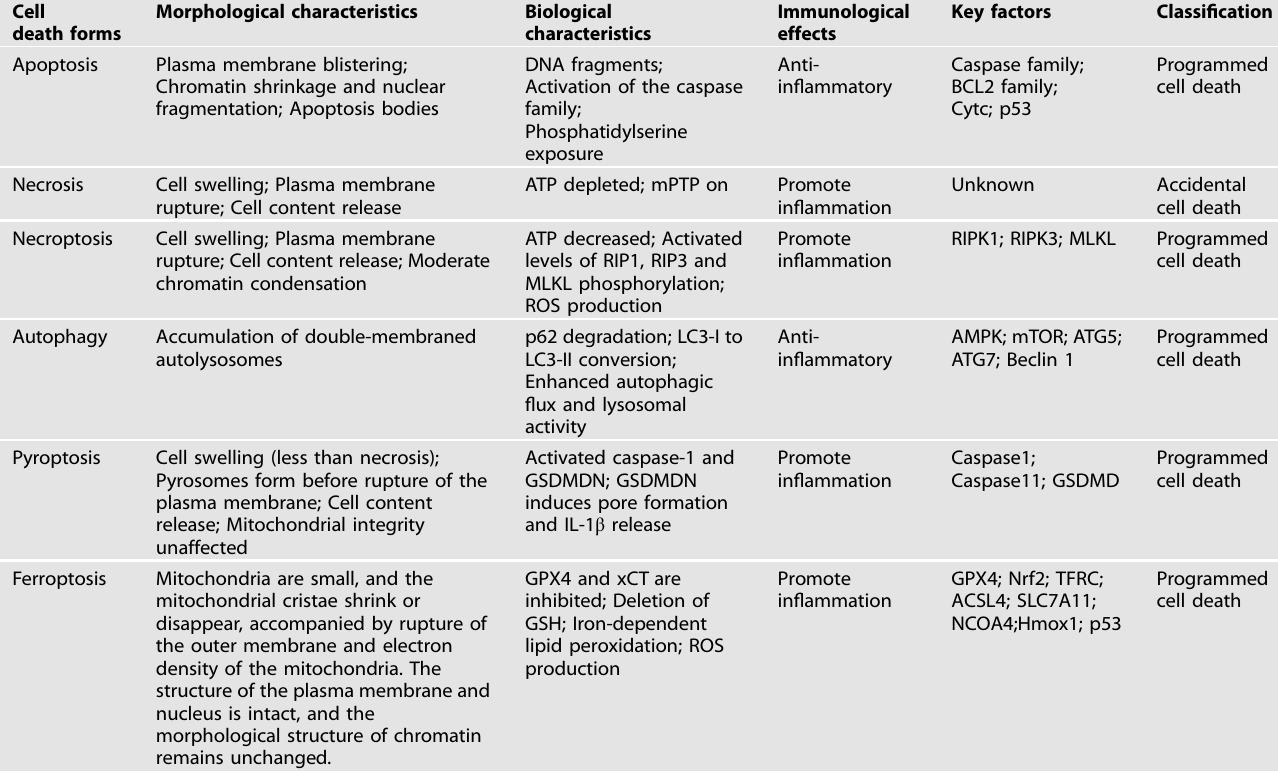
Table 1. Differences in diverse types of cell